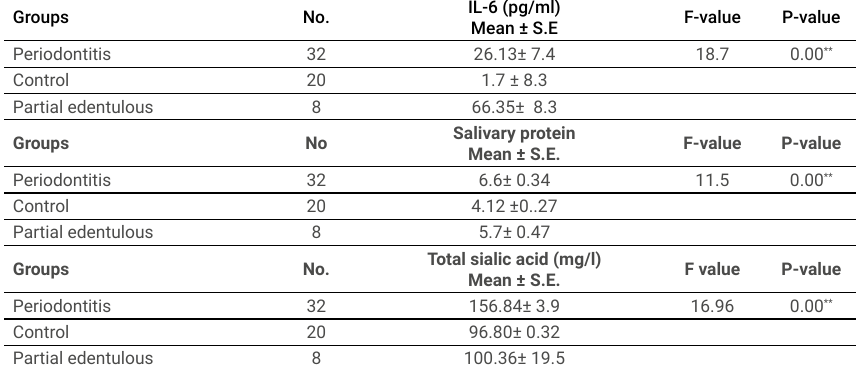
Table 1. Mean levels of salivary; IL-6, protein, and total sialic acid Groups No.